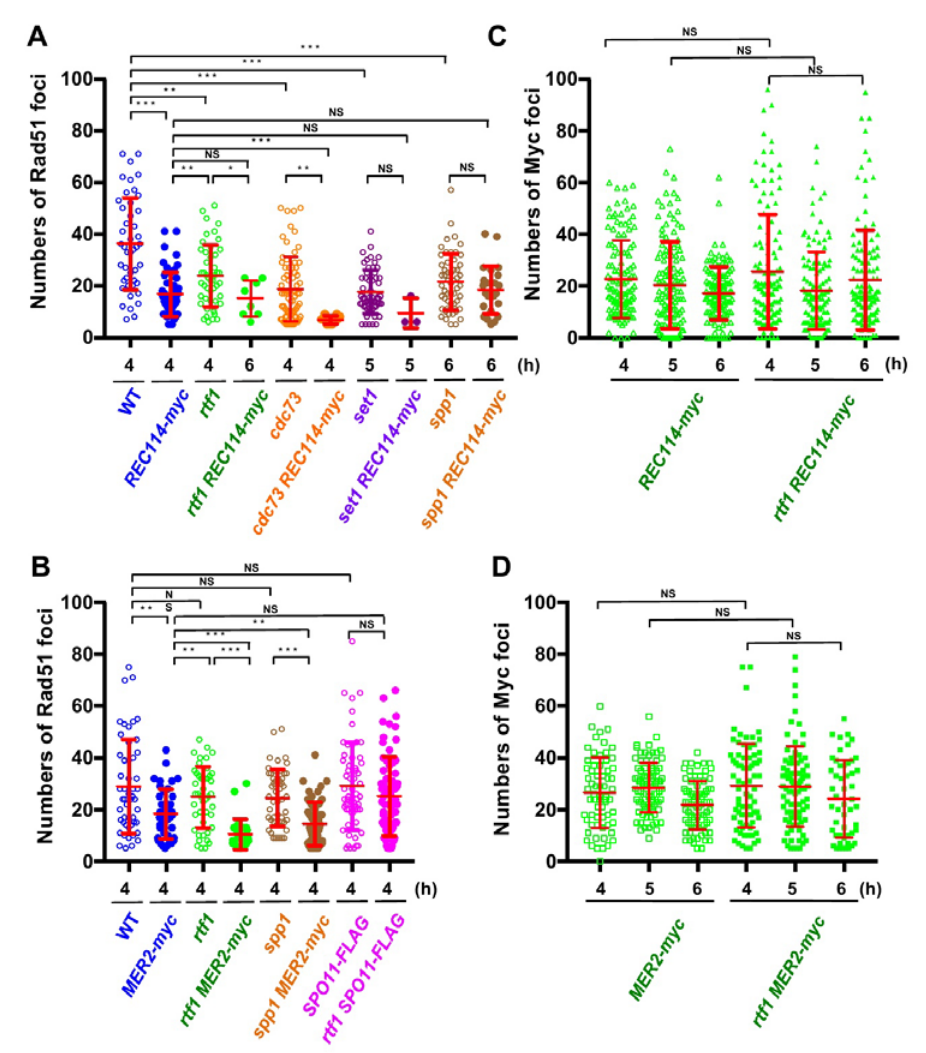
Figure 3. The REC114-myc showed a synthetic defect in Rad51-foci formation with histone modification mutations. ( A , B ) Distribution of Rad51 foci numbers. The number of Rad51 foci in foci-positive nuclei (with more than 5 foci) in strains with the REC114-myc ( A ) and the MER2-myc and SPO11-FLAG ( B ) at indicated times were counted. At each time point, 42 spreads from three independent time courses ( n = 126; 42 × 3) were analyzed. * p < 0.05; ** p < 0.01; *** p < 0.001. NS shows Not Significant. The p values and statistics for Rad51-foci numbers in foci-positive nuclei are shown in Table S2. The strains used are shown in Figure 1A. spp1 MER2-myc , ZYY1030; SPO11-FLAG ZYY1031; rtf1 SPO11-FLAG , ZYY1032. ( C , D ) Distributions of Rec114-myc- and Mer2-myc-foci numbers at 4, 5, and 6 h are shown. In REC114-myc ( C ), the number of myc foci in all spreads is shown. In MER2-myc (D), the number of myc foci in foci-positive nuclei (with more than 5 foci) is shown. At each time point, 42 spreads from three independent time courses ( n = 126; 42 × 3) were analyzed. The p values and statistics are shown in Table